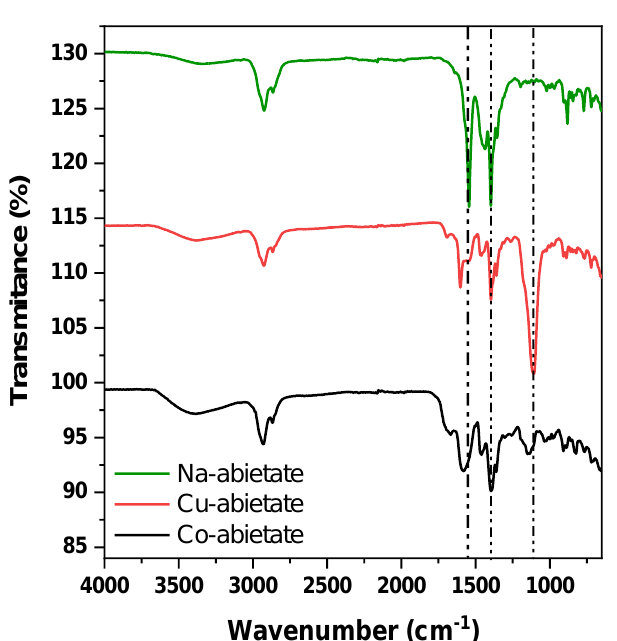
Figure 1. FTIR spectra of Na-abietate, the Co-abietate and Cu-abietate complexes. Table 1. υ as and υ s bands, ∆ υ , and coordinating mode obtained from the FTIR Spectra. Sample